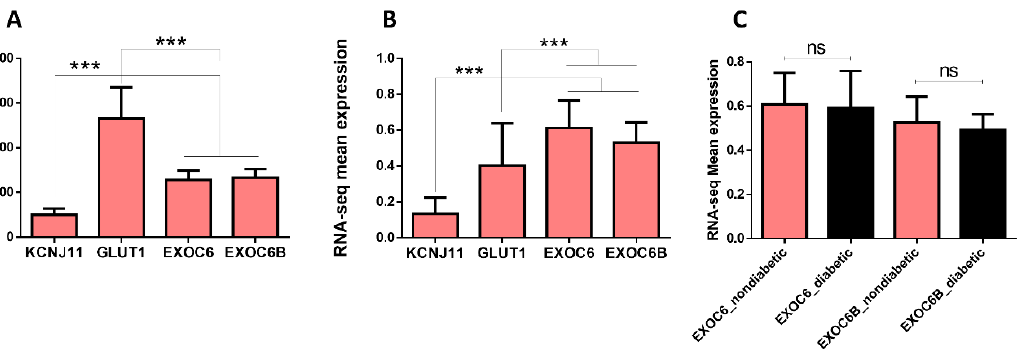
Figure 1. Expression of EXOC6/6b genes in human pancreatic islets. ( A ) Microarray mean ex- pression of KCNJ11, GLUT1, EXOC6 and EXOC6B in nondiabetic human islets ( n =45). ( B ) RNA sequencing expression of KCNJ11, GLUT1, EXOC6 and EXOC6B in nondiabetic human islets ( n =50). ( C ) Differential expression analysis (RNA-seq) of EXOC6 and EXOC6B in human islets obtained from diabetic/hyperglycemic donors ( n =27) compared to nondiabetic/normoglycemic donors ( n =50). ***; p < 0.001. n.s.; not significant. Bars represent mean ±